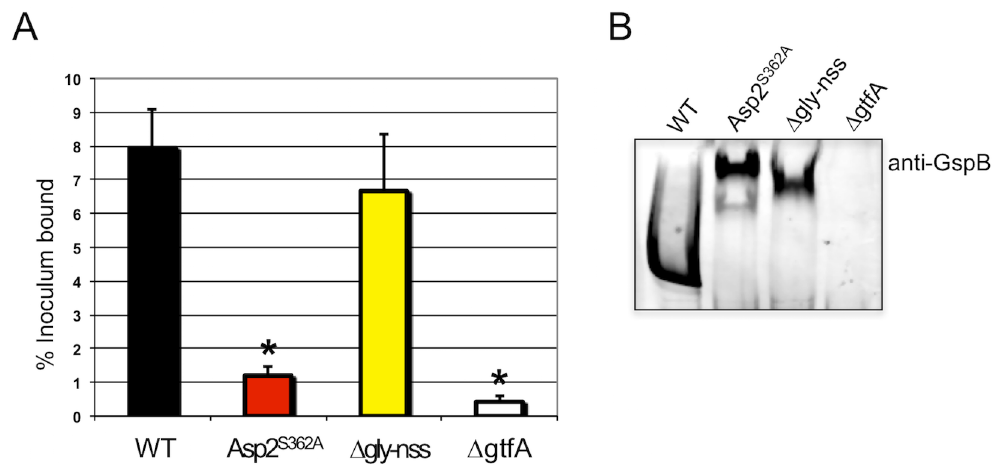
Fig 8. Binding of S . gordonii strains to human platelets. A) S . gordonii wild-typestrain M99 and isogenenic mutants PS3536(expressing the Asp2 S362A catalytic mutant), PS3319( Δ gly-nss ) and PS666 ( Δ gtfA ) expressing glycovariants of GspB were assessedfor their binding to immobilizedhumanplatelets. Bindingis expressedas the percent of input bacteria that remained bound to plateletsafter repeatedwashingof the wells. Bars indicate the means + S.D. of triplicate results from a representative experiment. * = P < 0.01, comparedwith wild-typeM99, one-wayANOVA, followedby post-hoc Tukey test. B) Expression of GspB and its glycoform variants on the surface of M99. Western blot analysisof cell fractions from the respective S . gordonii strains probedwith anti-GspB polyclonal antisera, showingfull-lengthGspB and its glycoform variants expressedon the surface of M99 at comparable levels. Of note, the Δ gtfA mutant does not express GspB on the bacterialsurface due to instability of the protein from a loss of glycosylation [12].